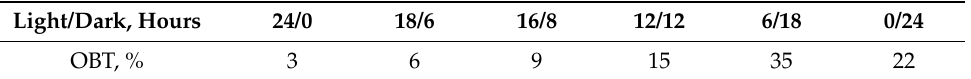
Table 2. OBT content (% of the total tritium content) in the plant biomass as a function of the illumination mode ( n = 5, p = 0.95).